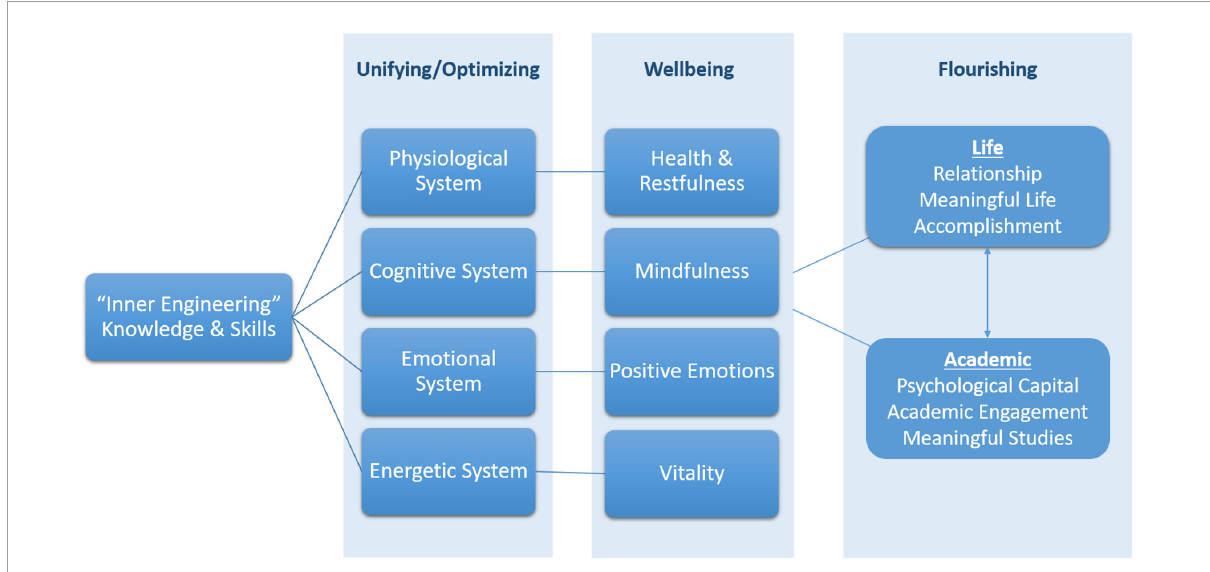
FIGURE1 The theoretical framework for the “Inner Engineering” approach toward wellbeing and